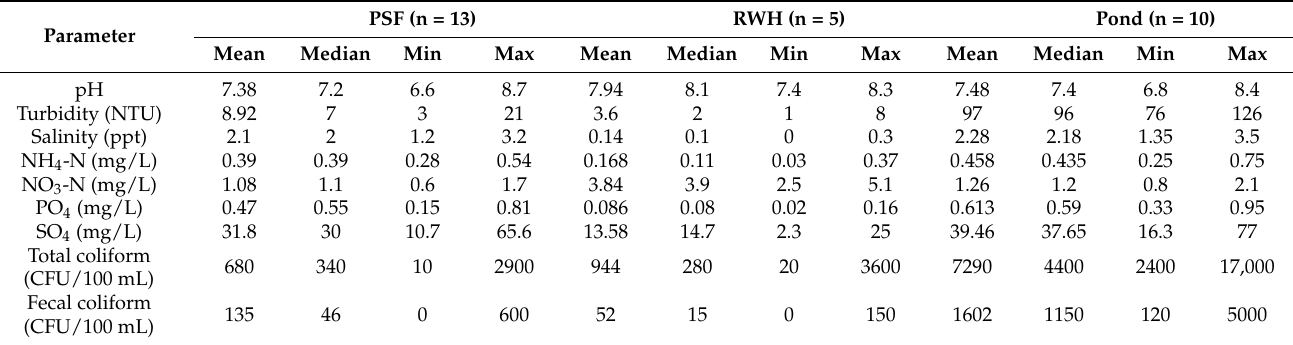
Table 5. Water quality parameters of PSF, RWH, and pond in Southkhali